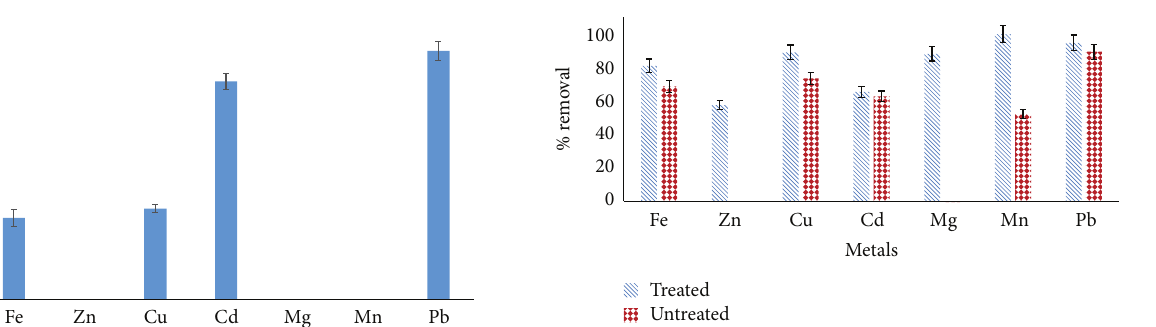
Figure 19: Percentage removal of metals from borehole water using MSP.